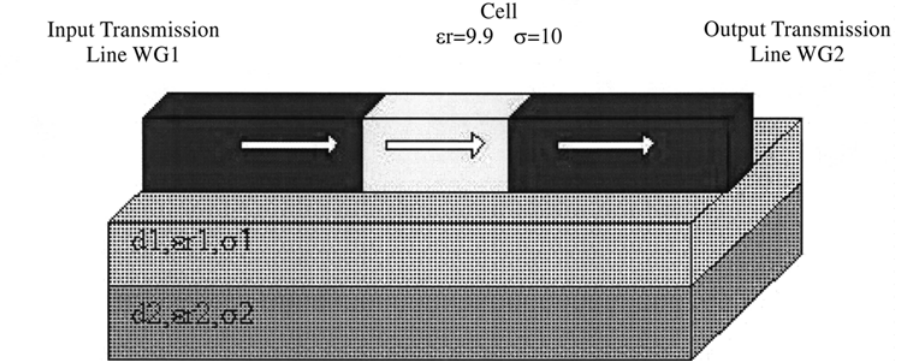
FIGURE 3 Application